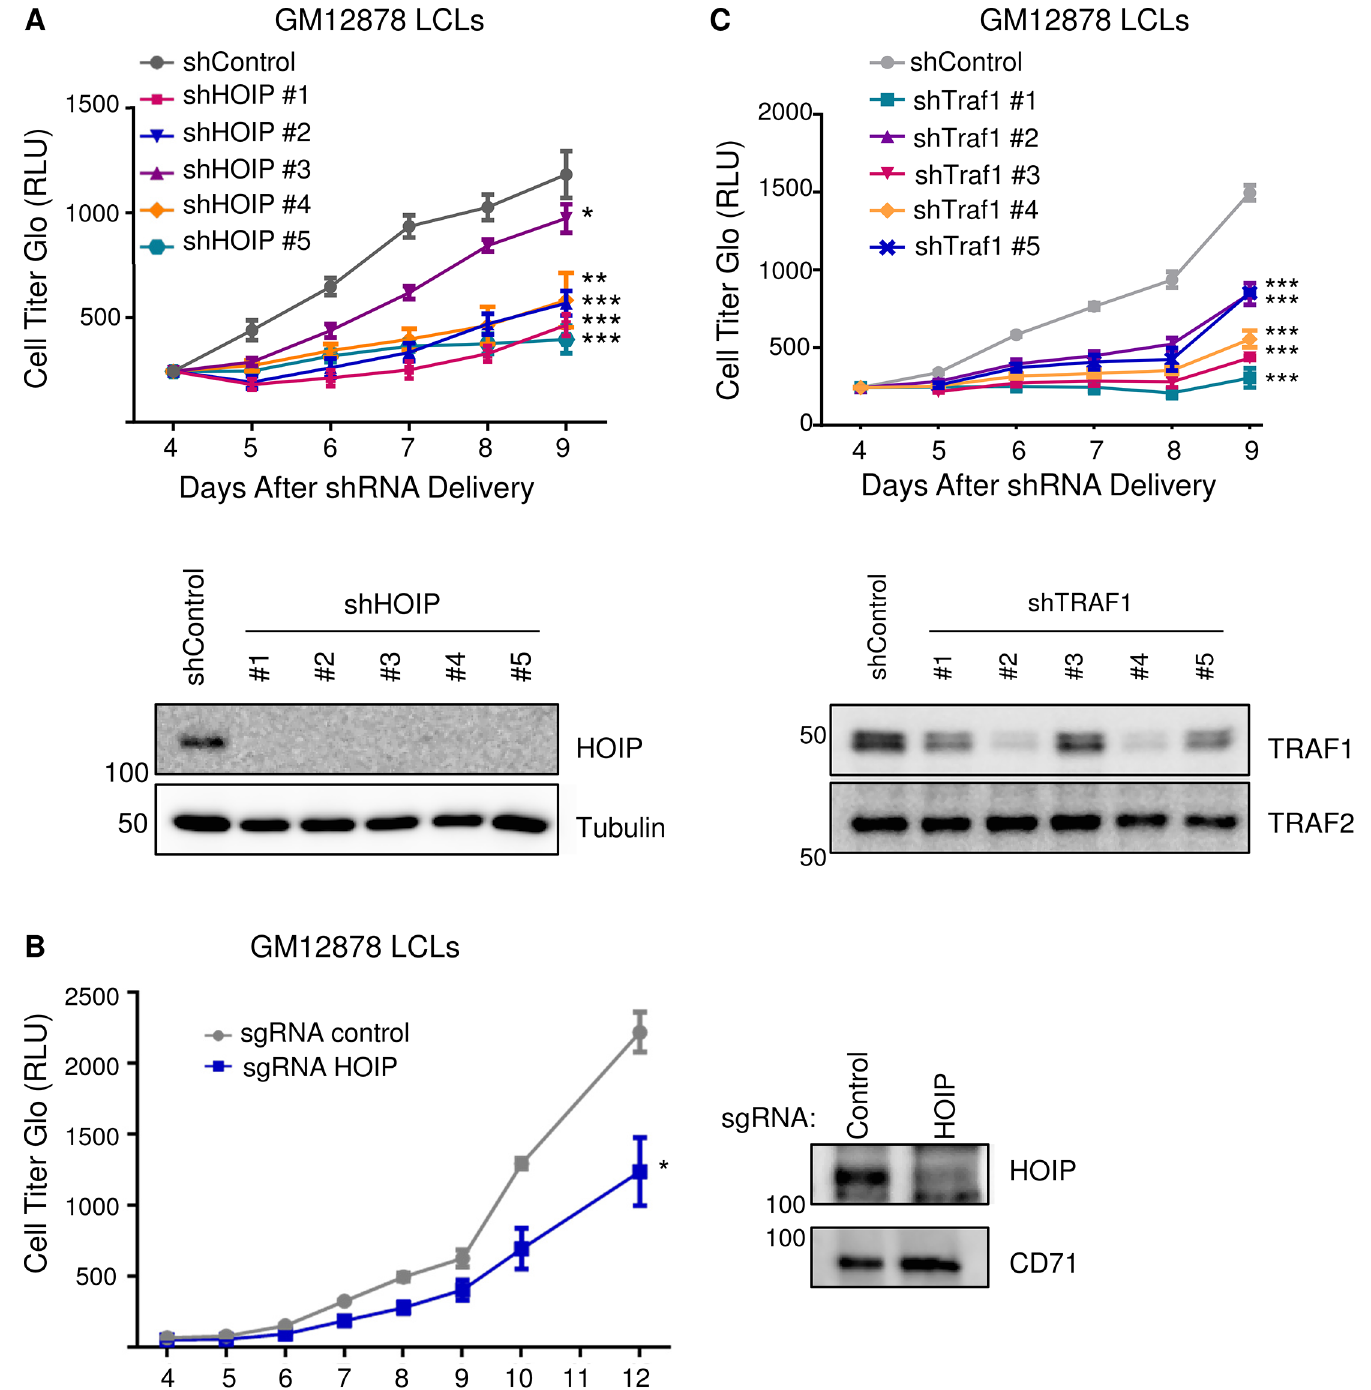
Fig 8. Depletion of HOIP or TRAF1 impairs LCL growth and survival. A) GM12878 LCLs were transduced with lentiviruses that express control shGFP or one of five independent anti-HOIP shRNAs on day 0. Transduced cells were selected with puromcyin on day 2 post-transduction, and then analyzed by quantitative CellTiter-Glo luminescent cell viability assays on the indicated days post transduction. Average and standard deviations from triplicate experiments are shown. WB whole cell lysates obtained four days after transduction are shown below the growth curves. B) GM12878 stable Cas9+ cells were transduced with lentiviruses that express a control anti-GFP sgRNA or an anti-HOIP sgRNA on day 0. Transduced cells were selected by puromcyin on day 2 post-transduction, and then analyzed by CellTiter-glo at the indicated timepoints post-transduction. Western blot of whole cell lysates from Day 6 post- transduction demonstrated HOIP depletion from the cell population. C) GM12878 LCLs were transduced with lentiviruses that express shGFP or one of five independent TRAF1 shRNAs. Transduced cells were selected with puromcyin on day 2, and then analyzed by CellTiter-Glo on the indicated days post-